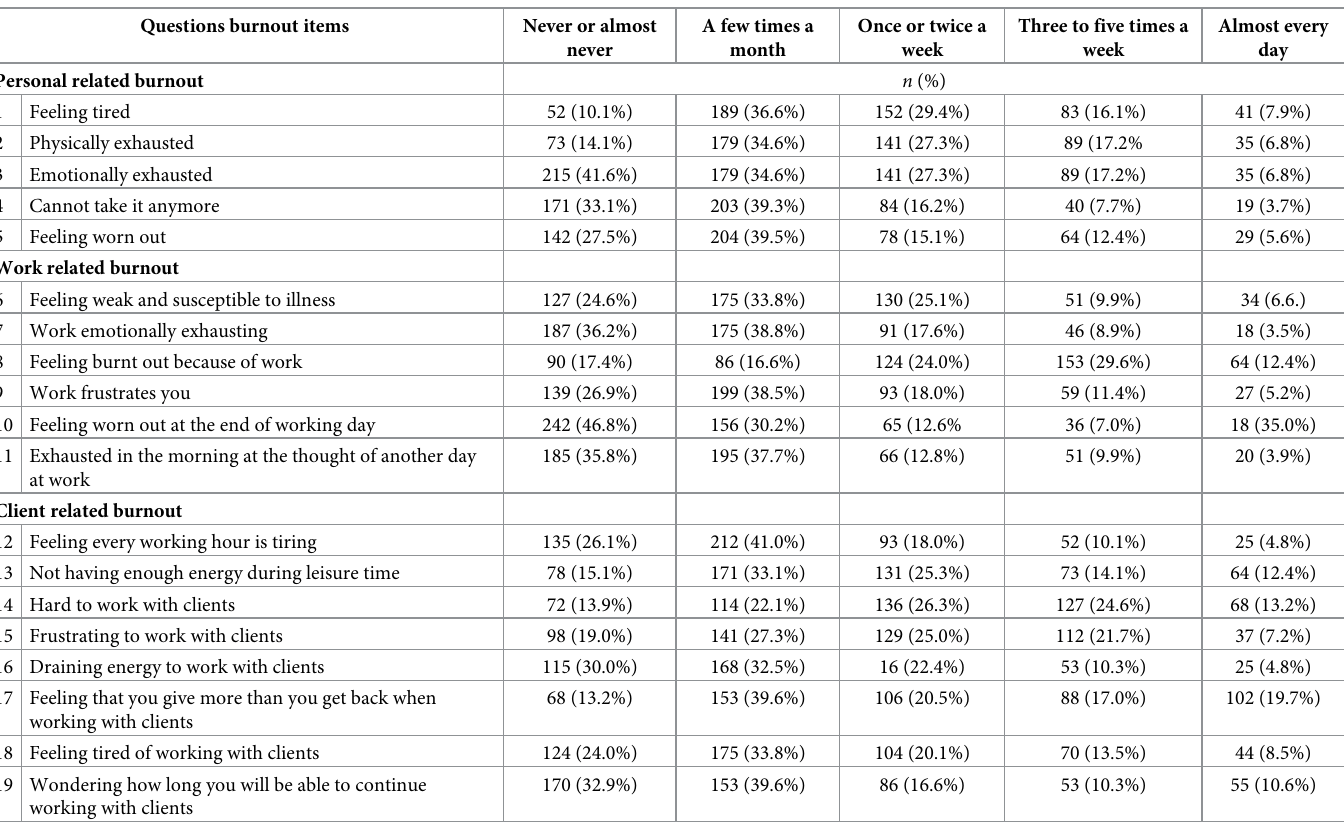
Table 2. Frequency of personal burnout